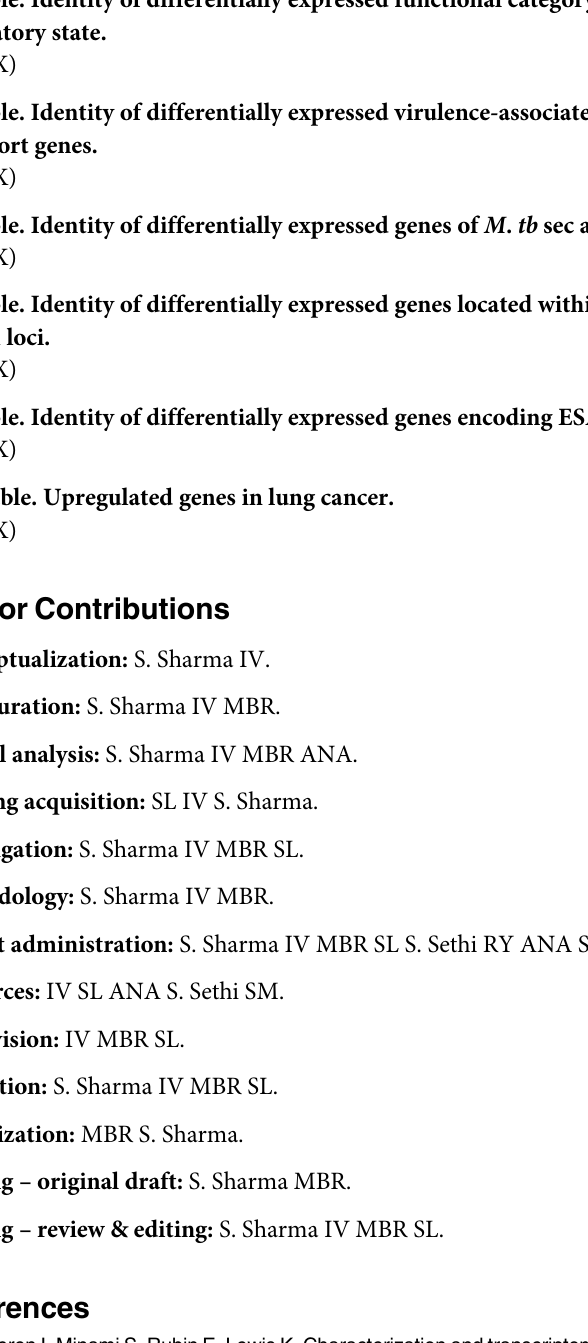
S4 Table. Identity of differentially expressed functional categories genes indicative of M . tb . S5 Table. Identity of differentially expressed functional category genes indicative of M . tb respiratory state. S6 Table. Identity of differentially expressed virulence-associated cell wall synthesis and transport genes. S7 Table. Identity of differentially expressed genes of M . tb sec and tat secretory pathways. S8 Table. Identity of differentially expressed genes located within ESX type VII secretion system loci. S9 Table. Identity of differentially expressed genes encoding ESAT-6-like proteins. (DOCX) S10 Table. Upregulated genes in lung